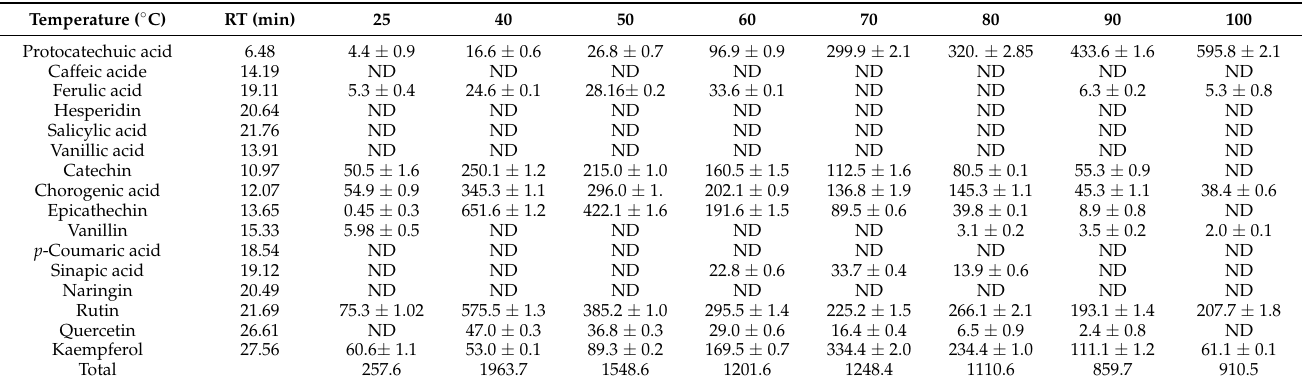
Table 2. Content of individual polyphenolic compounds of eight samples of treated argan powder determined by HPLC-DAD (mg/100 g DM).